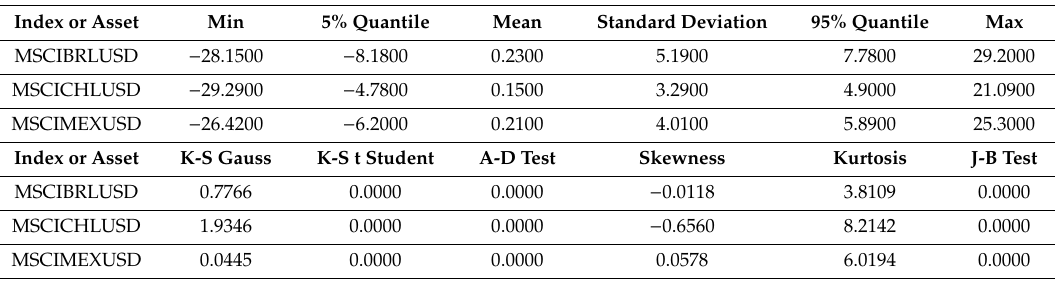
Table 2. Statistical summary of the weekly returns of the three stock indexes studied here (values as